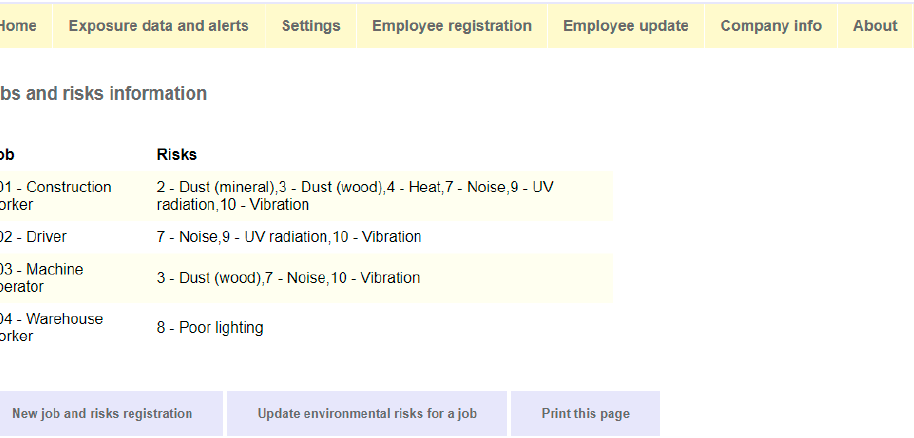
Figure 3. Example of registered jobs and risks.